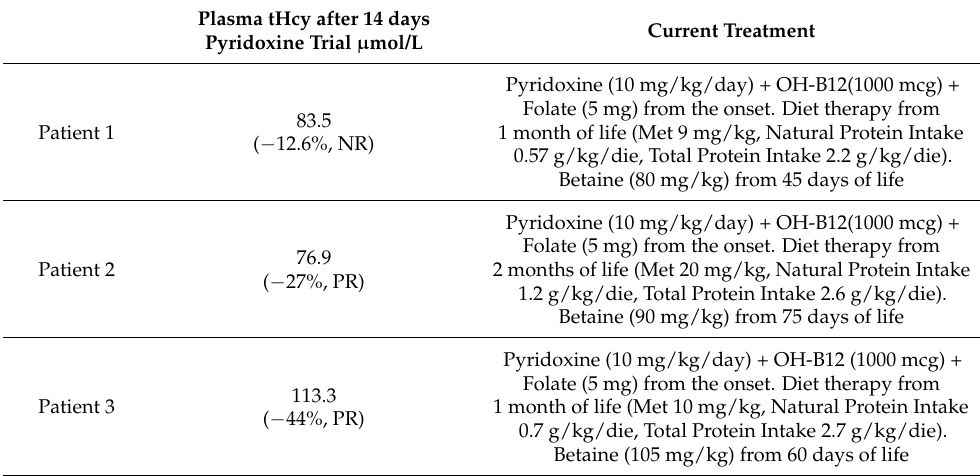
Table 3. Response to Pyridoxine trial, current therapy e metabolic control in our cases. PR = Partial Responder, ff the tHcy falls > 20% but remains above 50 µ mol/L. NR = Non-Responder, if the